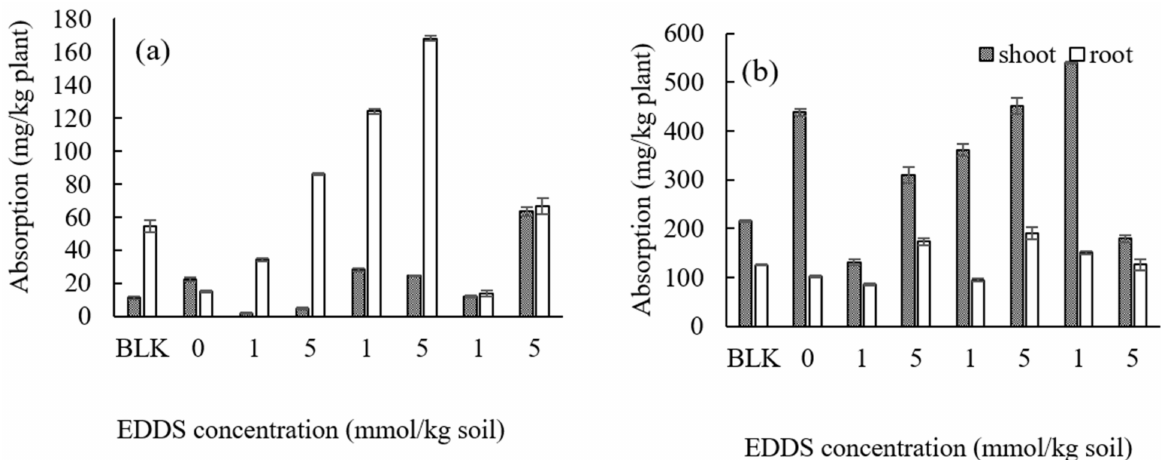
Figure 10. Effect of types and concentrations of chelating agents on the absorption of ( a ) Cd and ( b ) Zn in Gazania . BLK represents the pot for no addition of heavy metals (i.e., Al, Pb, Bi, and Ni) as well as no addition of chelating agents (i.e., Pot No. 1 in Table